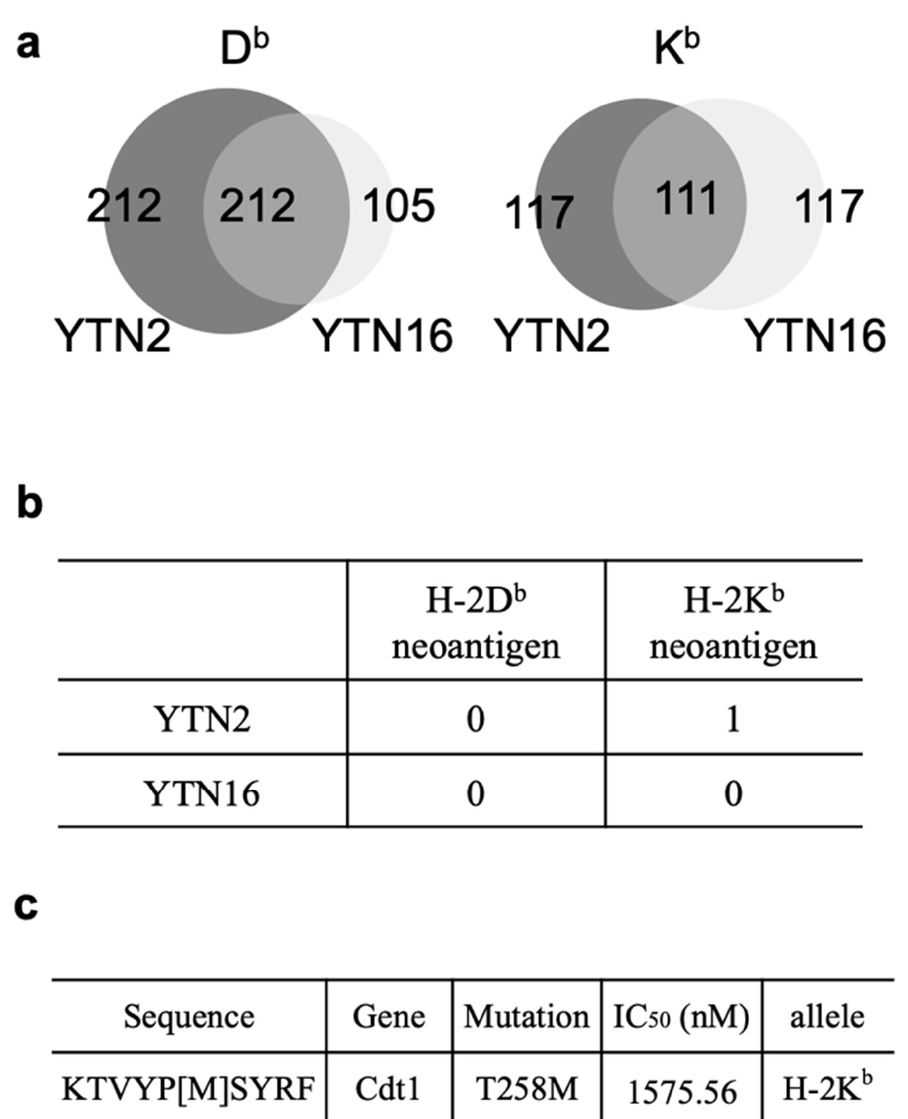
Figure 5. Identification of 10-mer mCdt1 peptides by MHC class I ligandome analysis: ( a ) Venn diagrams indicate the numbers of H-2D b - and H-2K b -binding peptides identified in YTN2 and YTN16. ( b ) The numbers of H-2D b - and H-2K b -mutated binding peptides identified in YTN2 and YTN16. ( c ) The amino acid sequence and predicted IC 50 value of the mCdt1 peptide identified in YTN2.